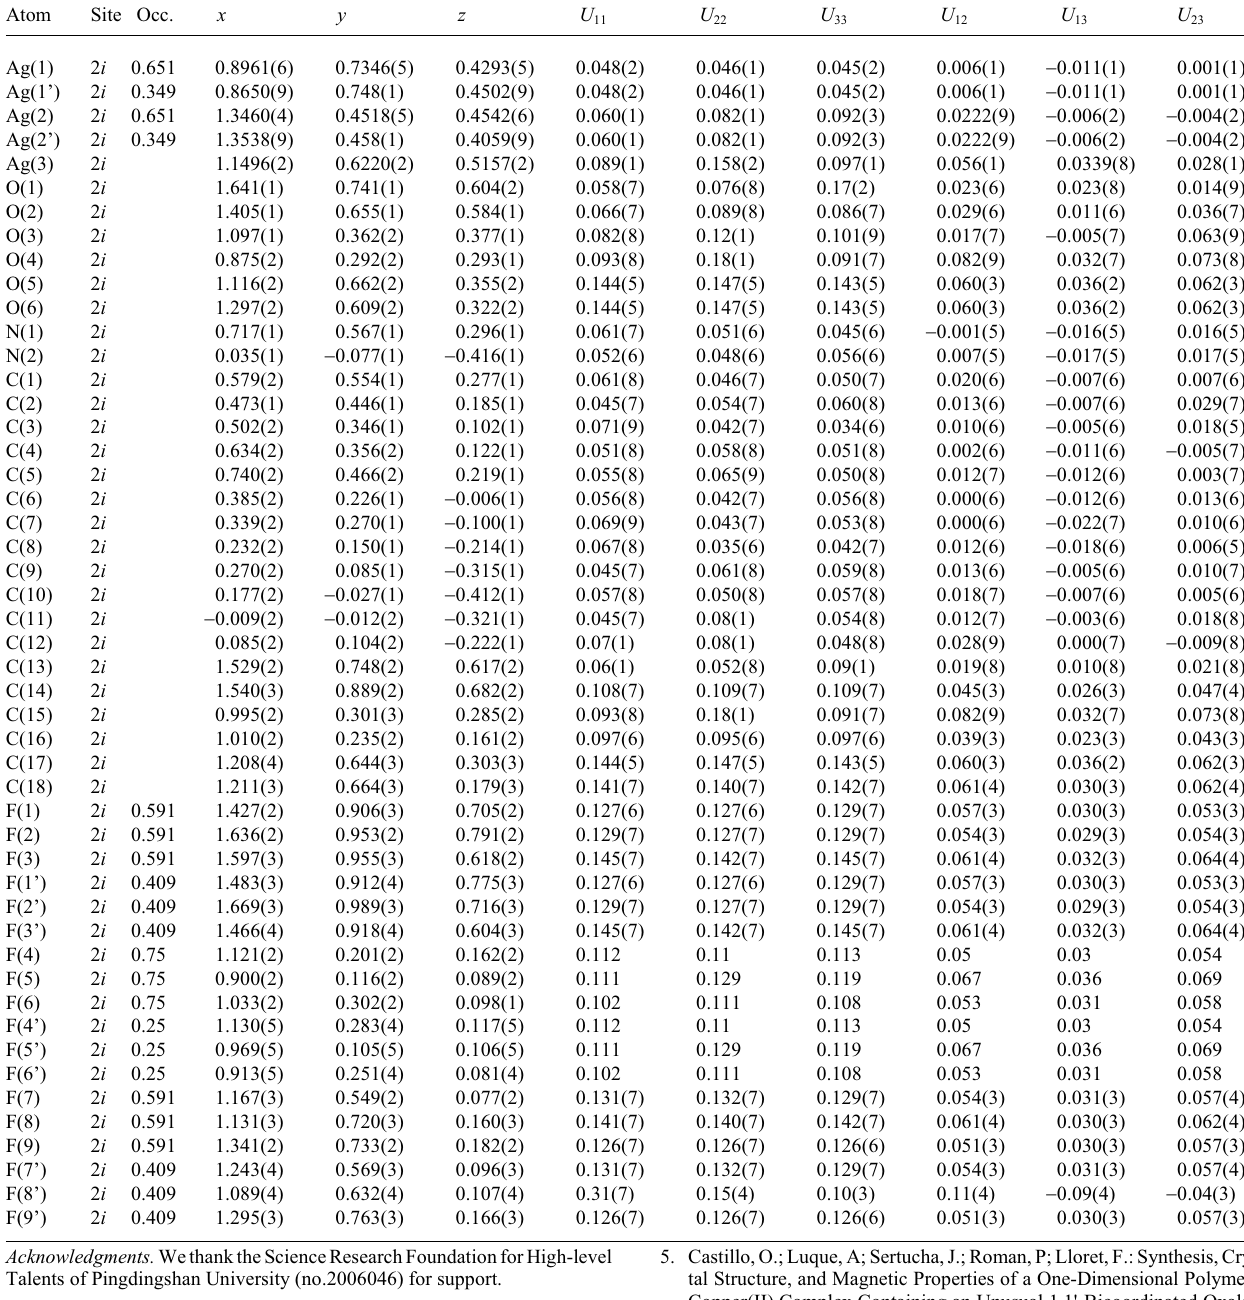
Table 3. Atomic coordinates and displacement parameters (in Å 2 ) . Atom Site